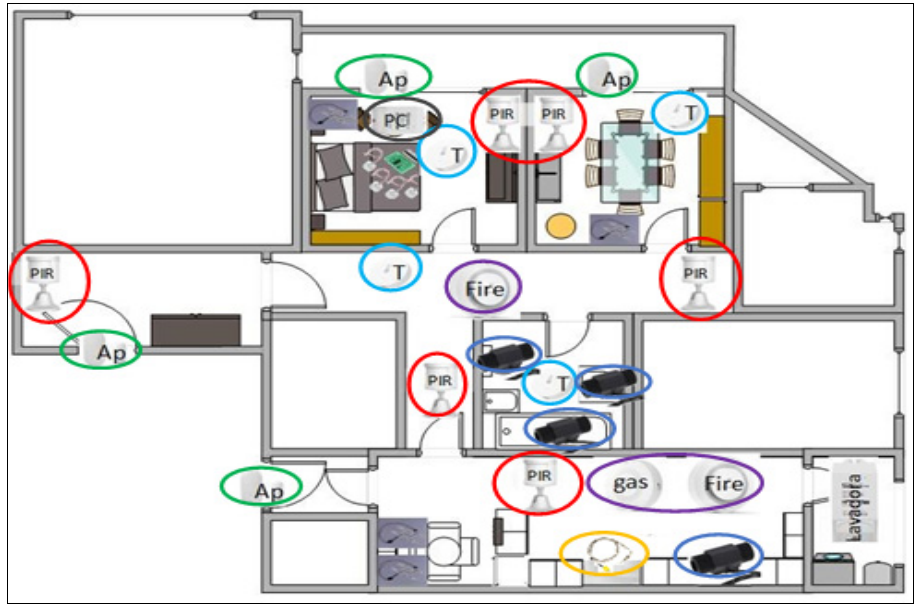
Figure 2. Distribution of home automation sensors. (AP = Opening/green, PIR = Presence/red, T = Temperature/light blue, PC = Electric consumption/black, gas = Natural gas/violet.)